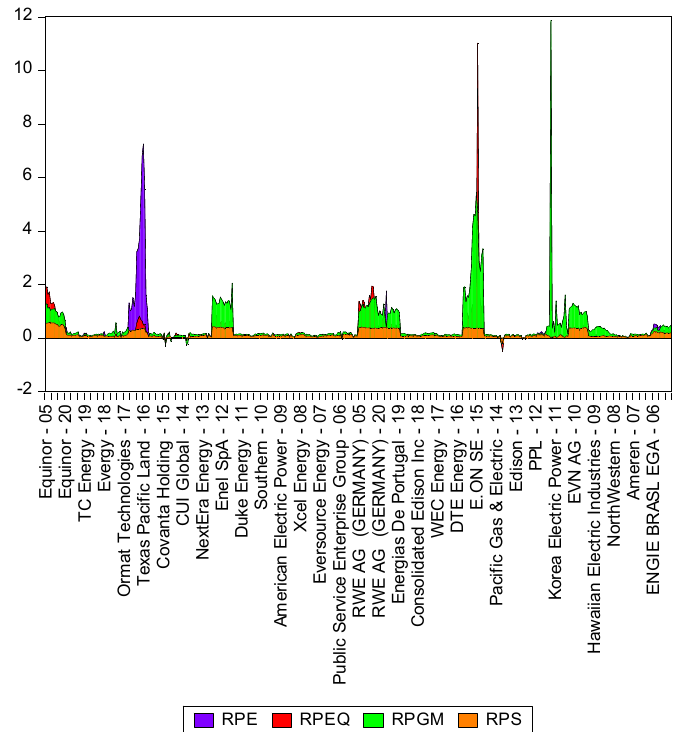
Figure 5. Evolution of fiscal pressure indicators for electricity companies. Note : The symbol RPE denotes the fiscal pressure to expenses ratio, RPEQ denotes the fiscal pressure to equity ratio, RPGM denotes the fiscal pressure to gross margin ratio, and RPS denotes the fiscal pressure to sales ratio.